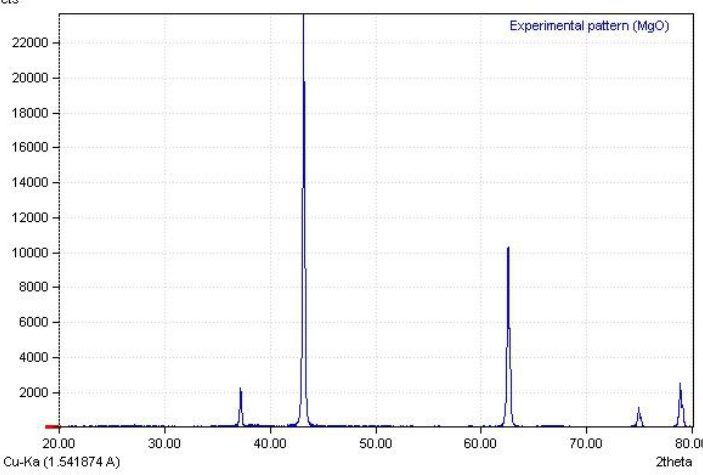
Figure 4. The X-ray diffraction diagram of MgO NPs.